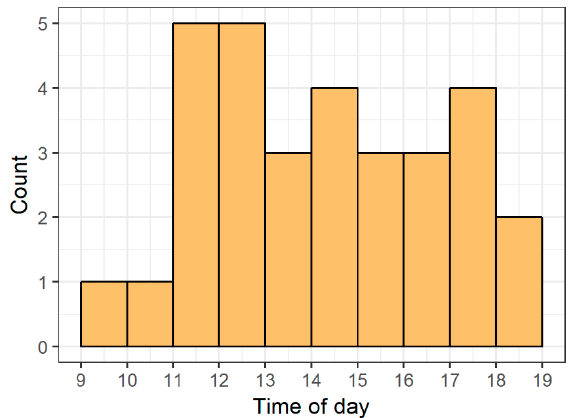
Figure 5. Probability of observing agonism during a ten-second window during each period type . Compared to baseline periods, zebrafish were significantly less agonistic during pre-feed and heightened-shoaling periods (both p ’s < 0.0001; 45 video clips, 450 ten-second windows, n = 6 tanks, 10 zebrafish per tank).